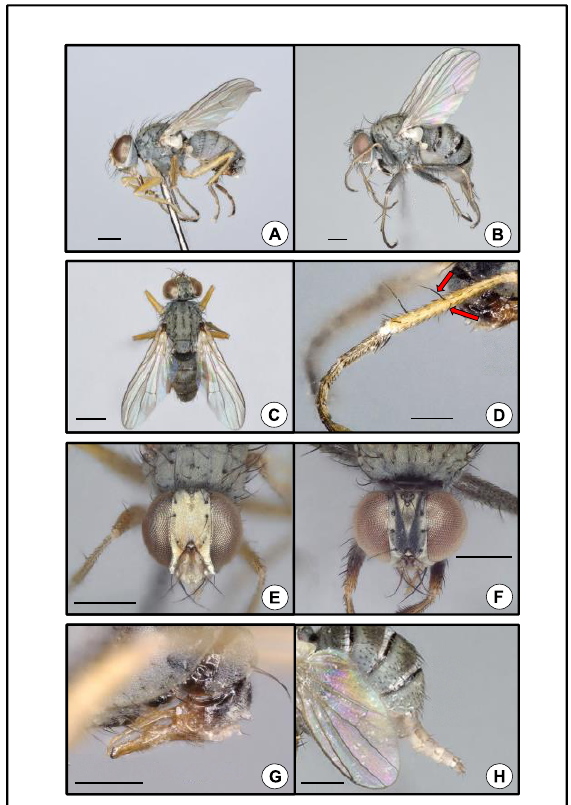
Figure 1. Coenosia attenuata. ( A ) Male, lateral. Scale bar = 0.5 mm. ( B ) Female, lateral. Note abdomen distended, exposing three black transverse stripes. Scale bar = 0.5 mm. ( C ) Male, habitus, dorsal. Scale bar = 0.5 mm. ( D ) Male, metathoracic tibia and tarsus, lateral. Arrows mark two major diverging setae at midlength. Scale bar = 0.25 mm. ( E ) Male, head, anterior. Scale bar = 0.5 mm ( F ) Female, head, anterior. Scale bar = 0.5 mm. ( G ) Male, abdominal terminalia, genitalia, lateral. Scale bar = 0.25 mm. ( H ) Female, abdominal terminalia, ovipositor, lateral. Scale bar = 0.5 mm.